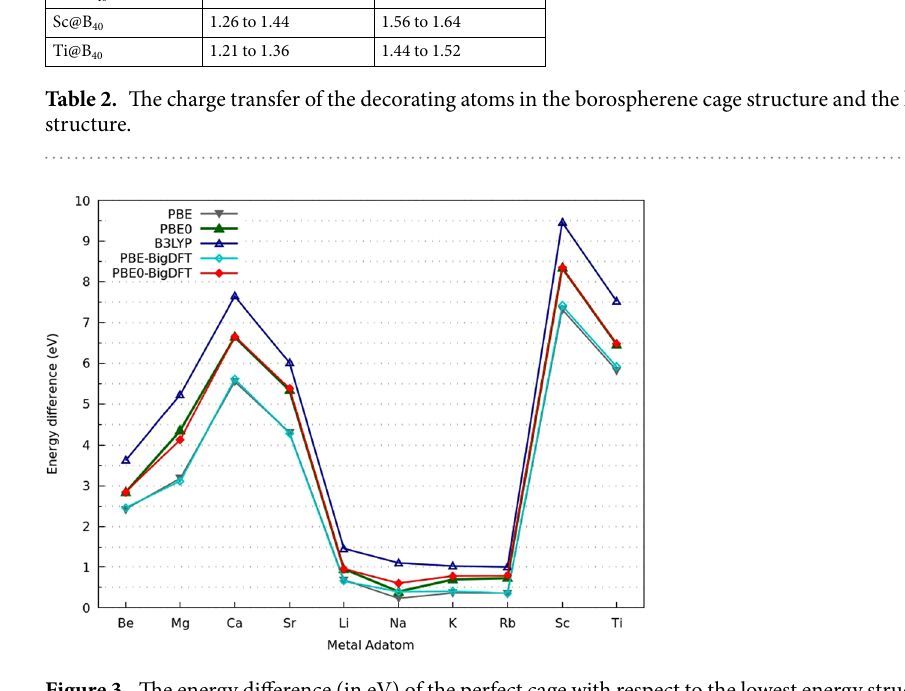
Figure 3. The energy difference (in eV) of the perfect cage with respect to the lowest energy structure of M 6 @ B 40 for different adatoms calculated with different exchange correlation functionals and two different codes, namely FHI-aims and BigDFT. Unless specified the calculations were done with the FHIaims